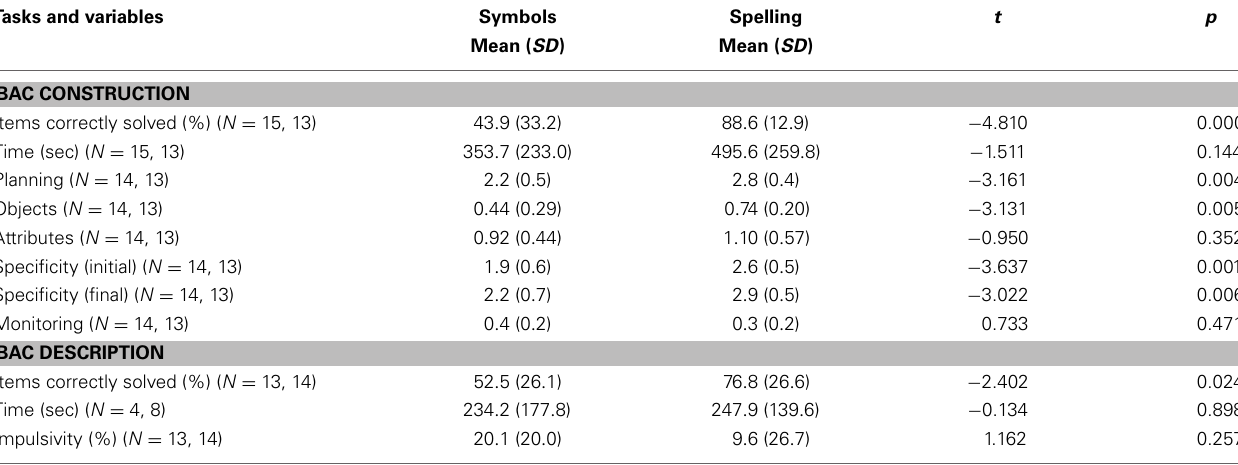
Table 6 | Task performance of aided communicators using symbols and spelling. Tasks and variables